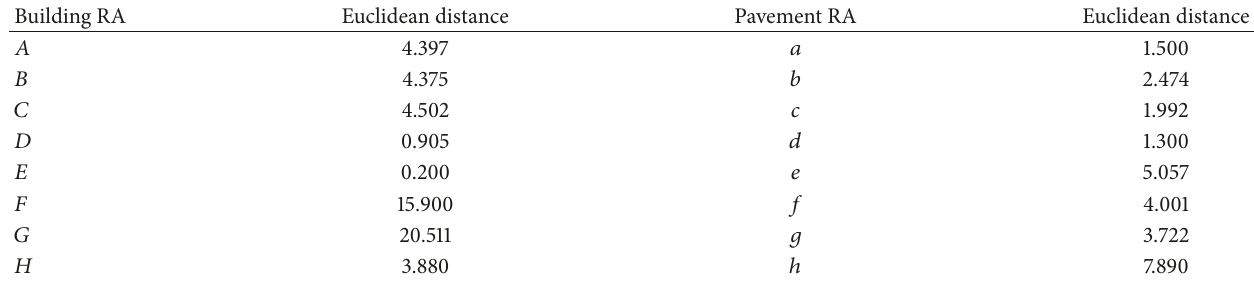
Table 5: Euclidean distance of whole property of building and pavement RA.